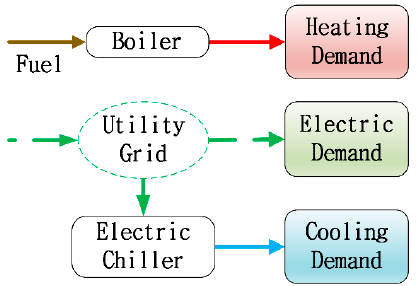
Figure 1. Block diagram of the reference system [13,19].